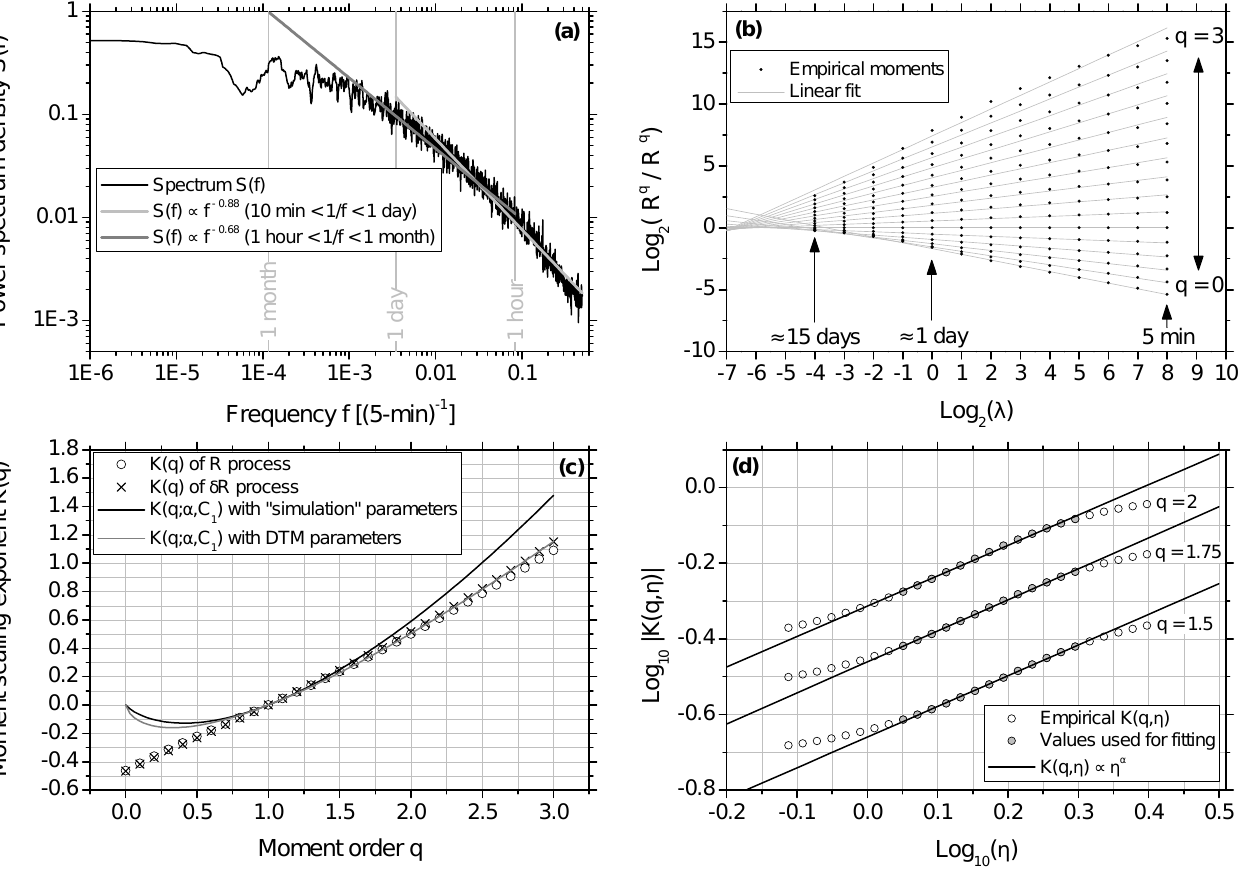
Fig. 1. (a) Power spectrum density (PSD) of the observed MFI series. Grey lines denote the power-law curves fitted on PSD for two different ranges of frequencies. (b) Traces of normalized moments, and corresponding moment-scale power-law relationships fitted to the data. (c) Empirical and CUM theoretical K(q) functions. (d) Patterns of | K(q,η) | resulting from the double trace moment (DTM) technique for q ={ 1 . 5 , 1 . 75 , 2 } . Straight lines represent the power-law fitted to the linear part of the patterns (grey points).